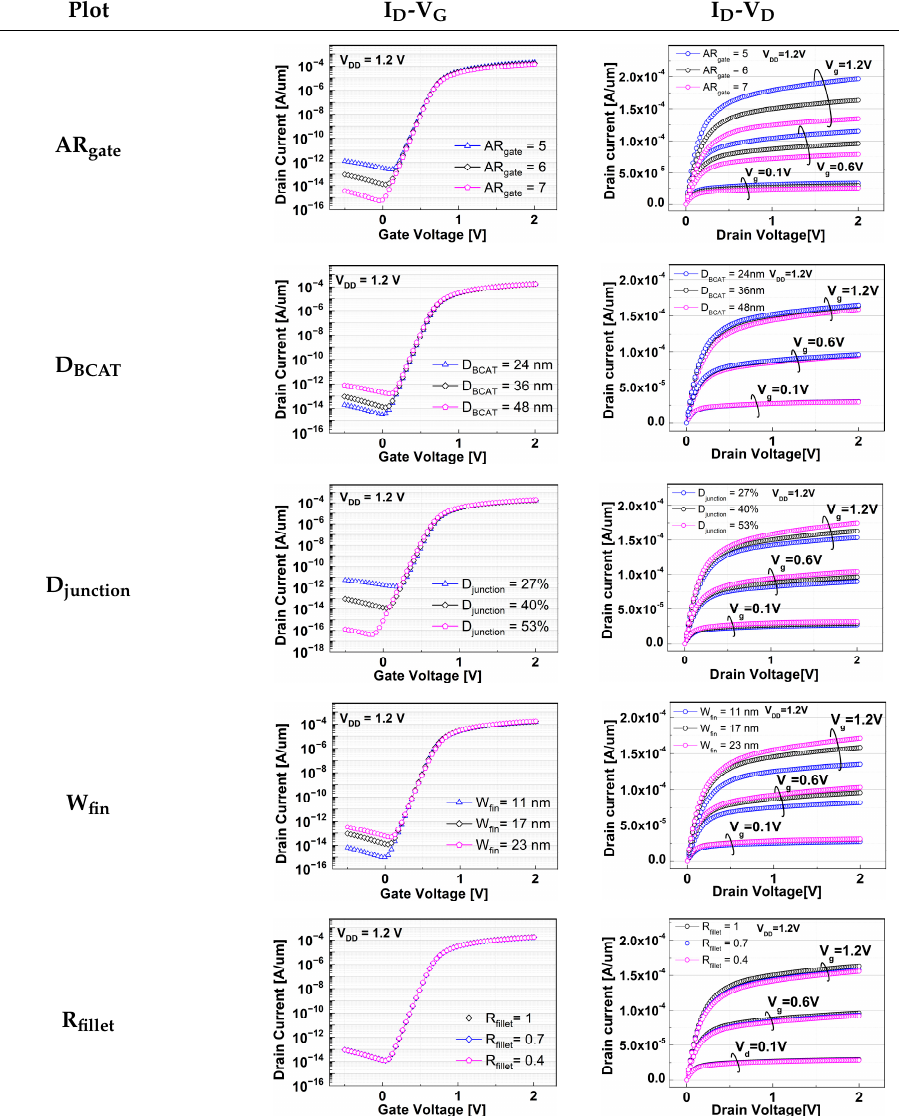
Figure 2. Parametric variations in the BCAT: ( a ) aspect ratio of the BCAT recess (D recess )-to-gate length (L gate ) (i.e., AR Gate = D recess /L gate ), ( b ) BCAT depth (D BCAT ), ( c ) junction depth (D junction ), ( d ) fin width (W fin ), and ( e ) fin fillet radius (R fillet ). Table 1. I D -V G and I D -V D of the BCAT for given parametric variations, including AR gate , D BCAT , D junction , W fin , and R fillet . Note that the drain current is normalized to the channel width. Plot I D -V G